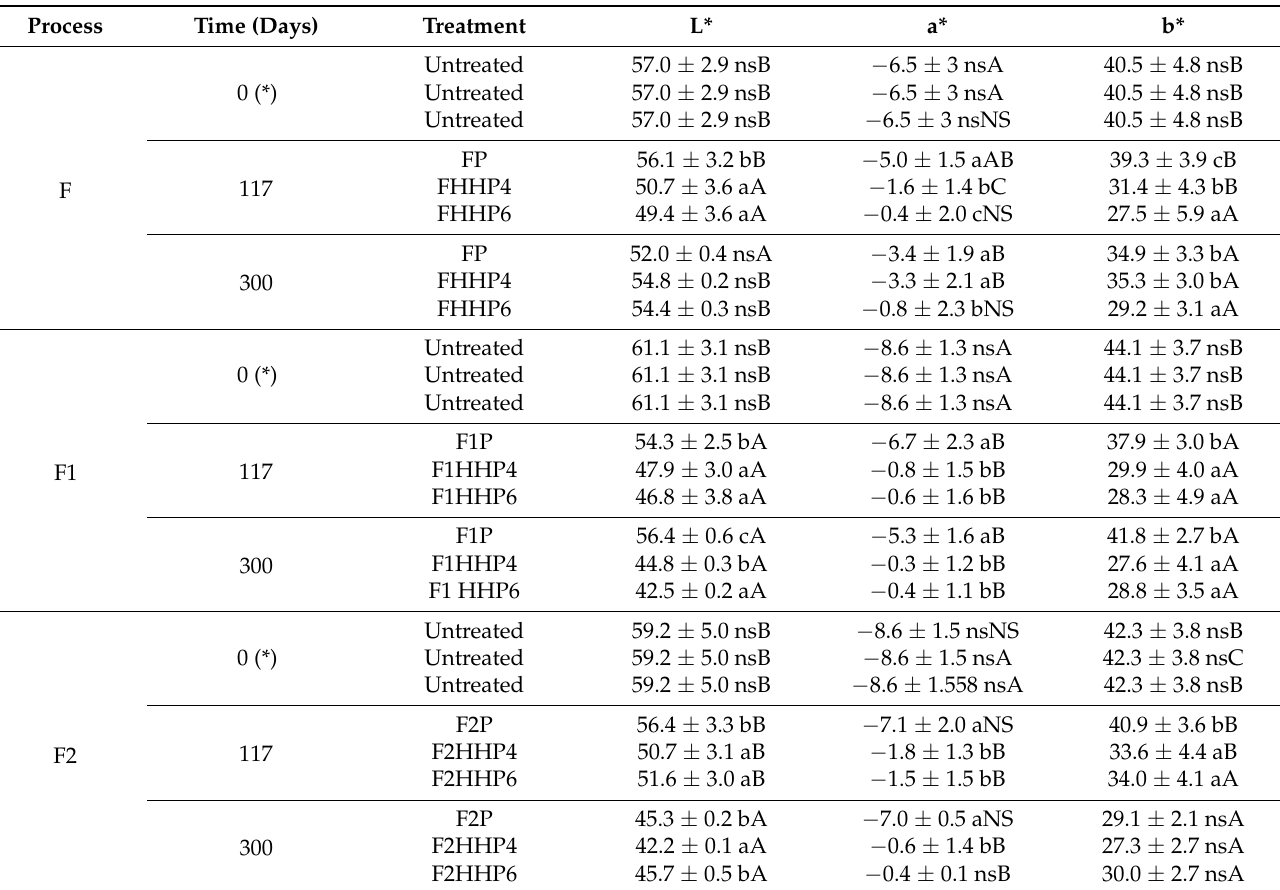
Table 2. Colour parameters (mean ± standard deviation). F: spontaneous fermentation of olives; F1: olives fermented with OLE + spontaneous fermentation; F2: olives fermented with OLE + S. cerevisiae; P: pasteurization treatment; FHHP4: high hydrostatic pressure treatment (400 MPa, 4 min); FHHP6: high hydrostatic pressure (400 MPa, 6